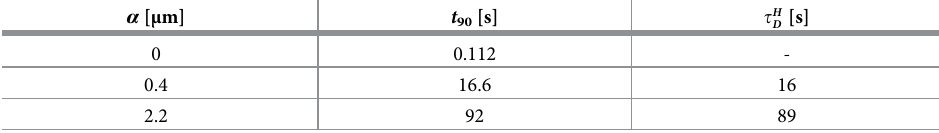
Table 2. Equilibration time for various values of the binding equilibrium constant α .